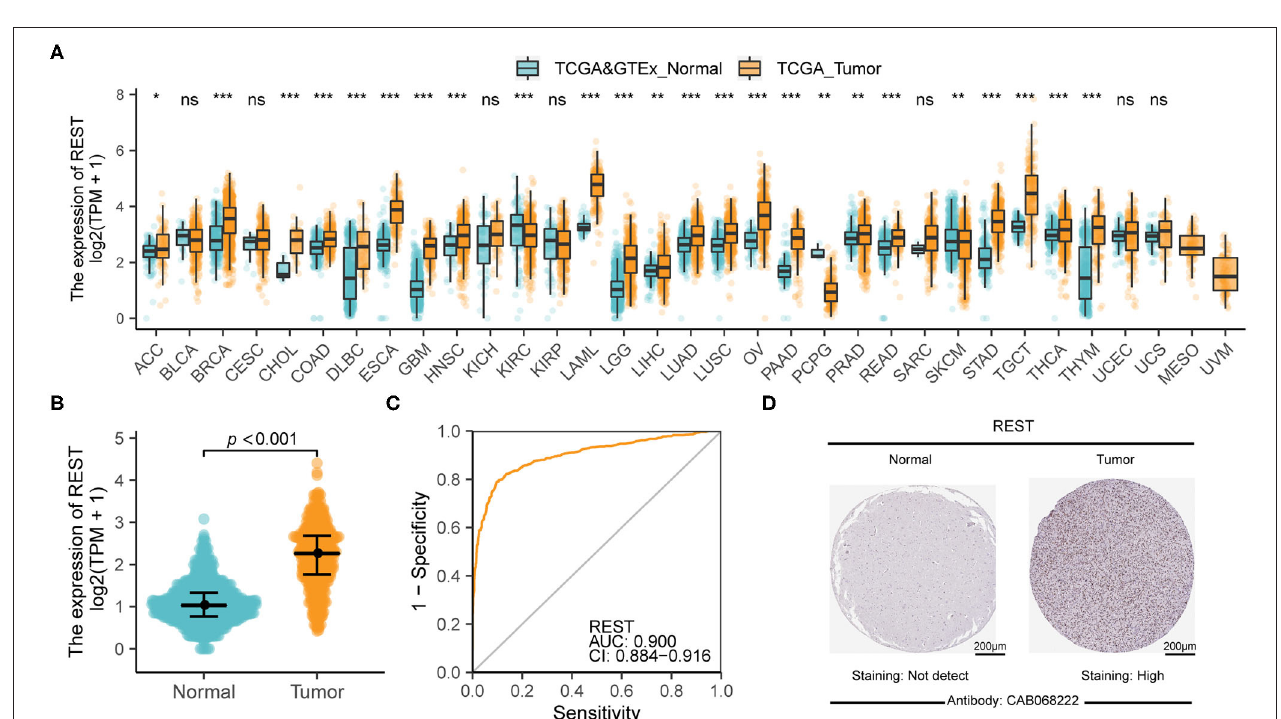
FIGURE 2 | REST was significantly up-regulated in glioma. (A) The difference of REST expression in pan-cancer and adjacent tissues. (B) REST differential expression analysis between glioma samples in TCGA database and normal brain samples from TCGA and GTEx databases. (C) The diagnostic value of REST in glioma. (D) The representative immunohistochemical images of REST in the Human Protein Atlas database of glioma and normal tissues. All data are shown as mean ± SD, * P < 0.05, ** P < 0.01, and *** P < 0.001.